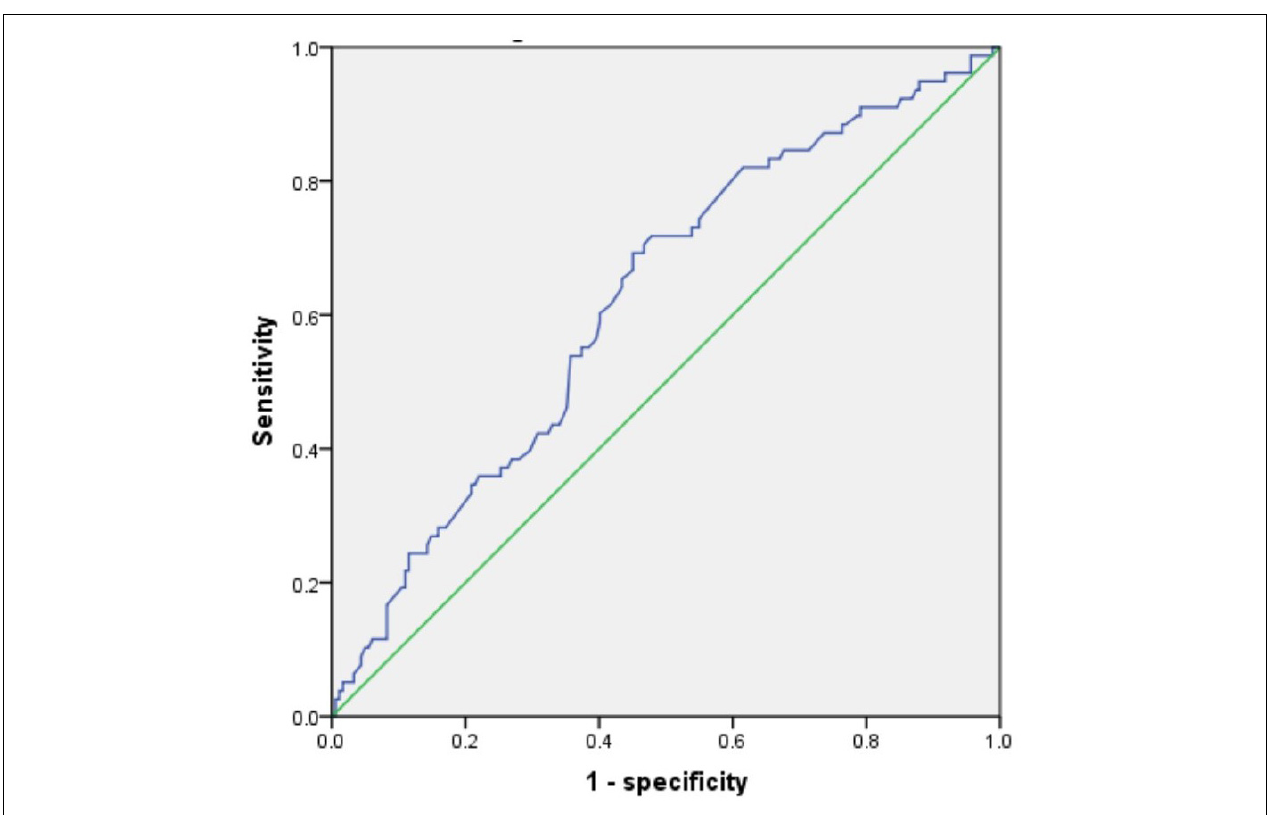
FIGURE 2 | The ROC curve of AST/ALT for predicting the future occurrence of aMCI. AST, aspartate aminotransferase; ALT, Alanine